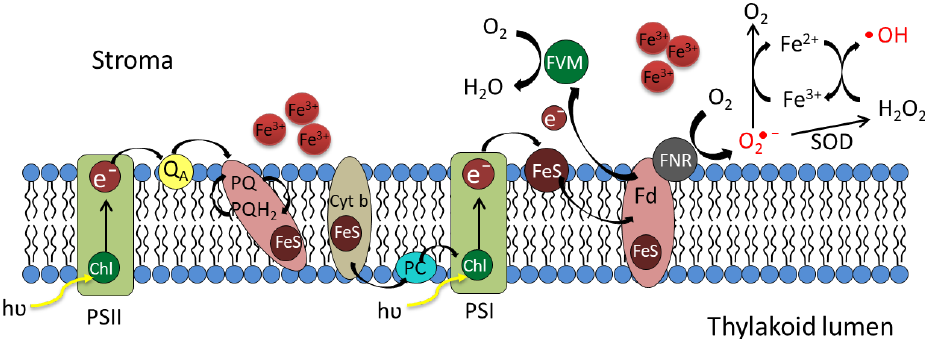
Figure 8. Schematic mechanism proposed for the oxidative stress induction in C. onubensis , linked to the photosynthetic chloroplast electron transport chain when Fe (III) is added. PSII: photosystem